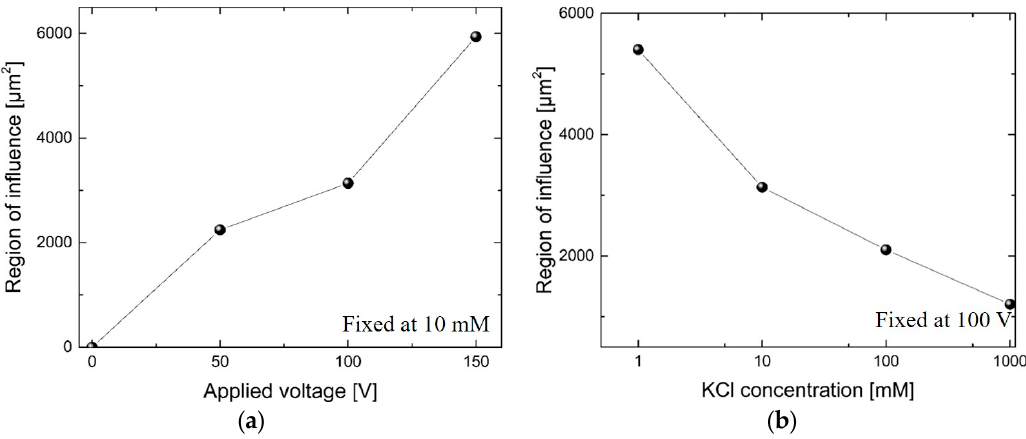
Figure 4. Region of influence of vortex generation versus ( a ) applied voltage and ( b ) KCl concentration.